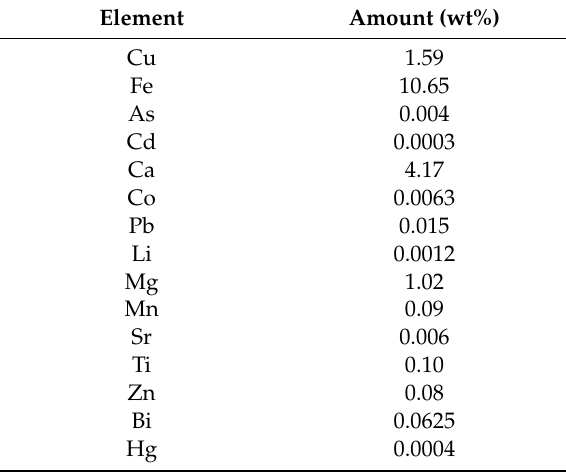
Table 2. Elements contained in the copper oxide ore in